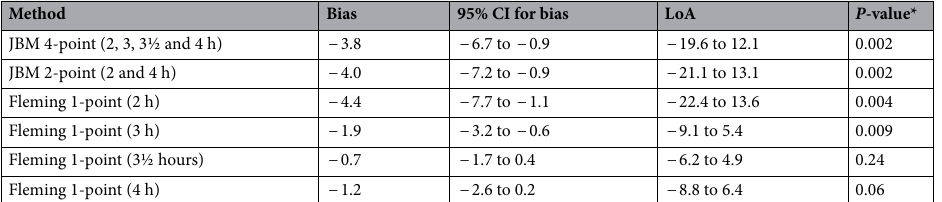
Table 1. Bland–Altman data comparing mGFR estimates (mL/min/1.73 m 2 ) based on samples taken from the ipsilateral and contralateral arm. CI confidence interval, LoA limits of agreement, JBM Jødal–Brøchner– Mortensen. * P -value calculated by the Wilcoxon signed rank test (testing symmetry around